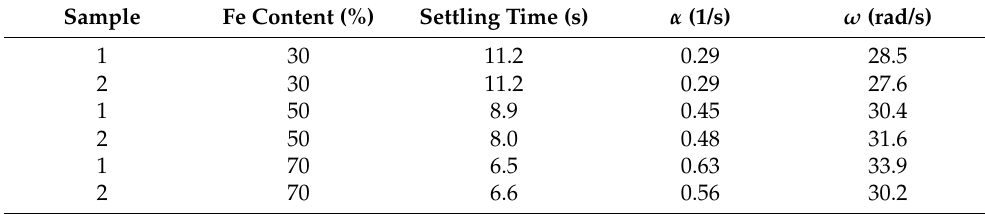
Table 4. The settling time of free oscillations for samples of beams with different iron content in MRE. Sample Fe Content